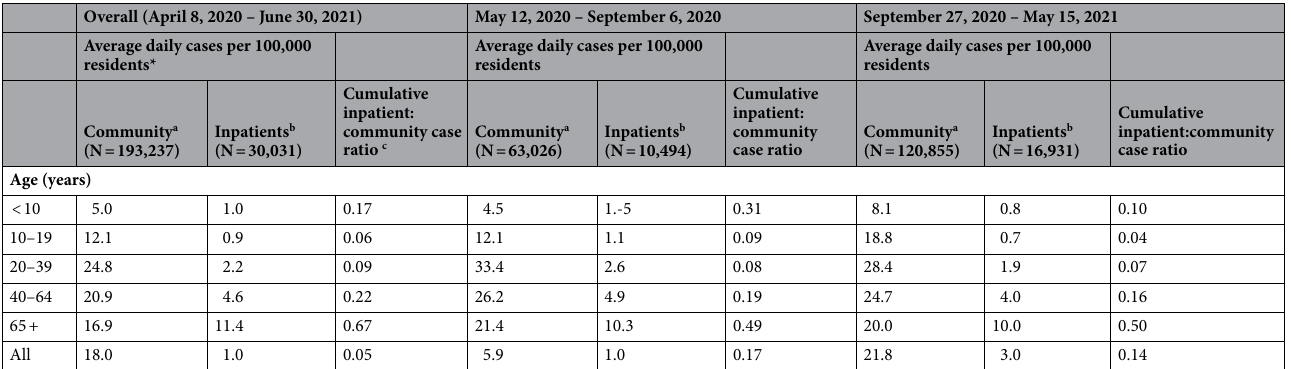
Table 1. Daily growth rates* in SARS-CoV-2 cases per 100,000 residents during outbreak waves in Harris County, TX, stratified by age group. * New cases/day in 100,000 population; a SARS-CoV-2 confirmed cases in Harris County community; cases include all local SARS-CoV-2 infections; b Harris County